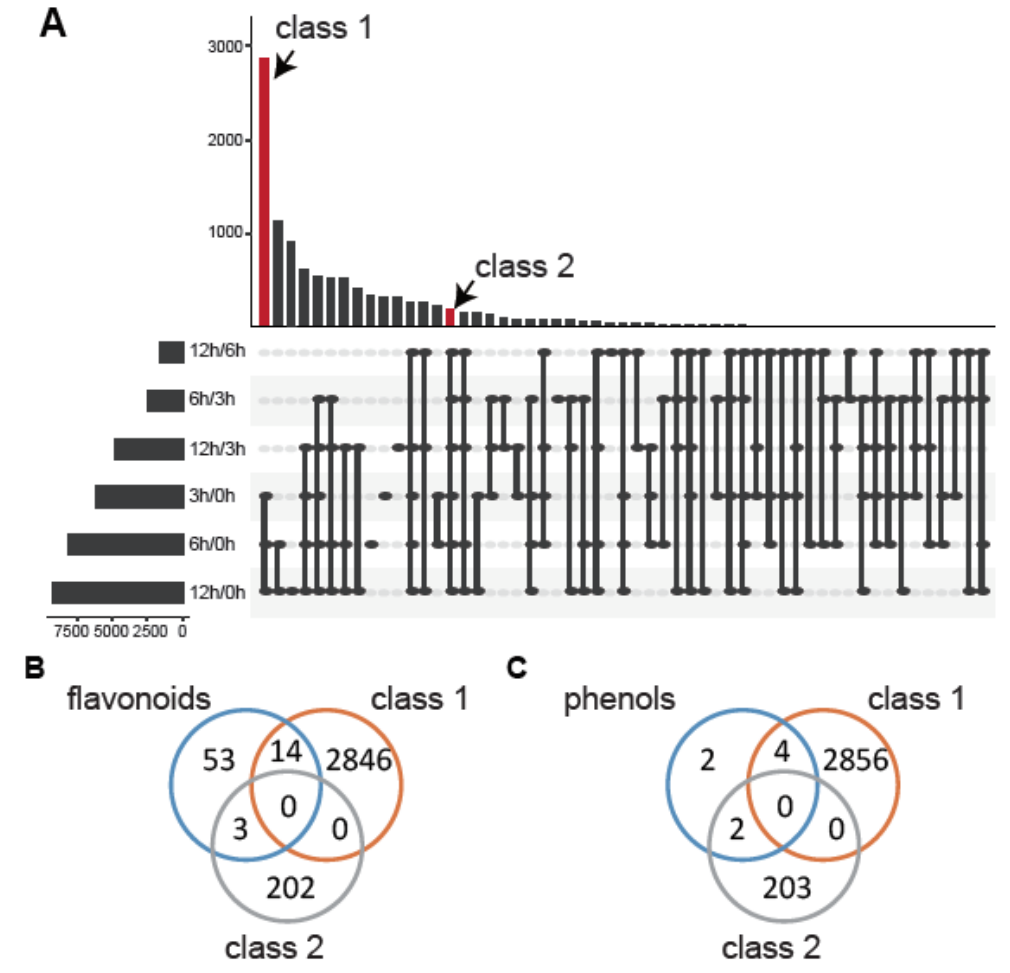
Figure 6. Selection of metabolic genes under Al stress. ( A ) The Venn analysis for the DEGs of different groups (3 h / 0 h, 6 h / 0 h, 12 h / 0 h, 6 h / 3 h, 12 h / 3 h, and 12 h / 6 h). Class 1 is the DEGs that appeared in the groups 3 h / 0 h, 6 h / 0 h, and 12 h / 0 h. ( B ) The core genes in the flavonoid-related pathway. ( C ) The core genes in the phenol-related pathway.